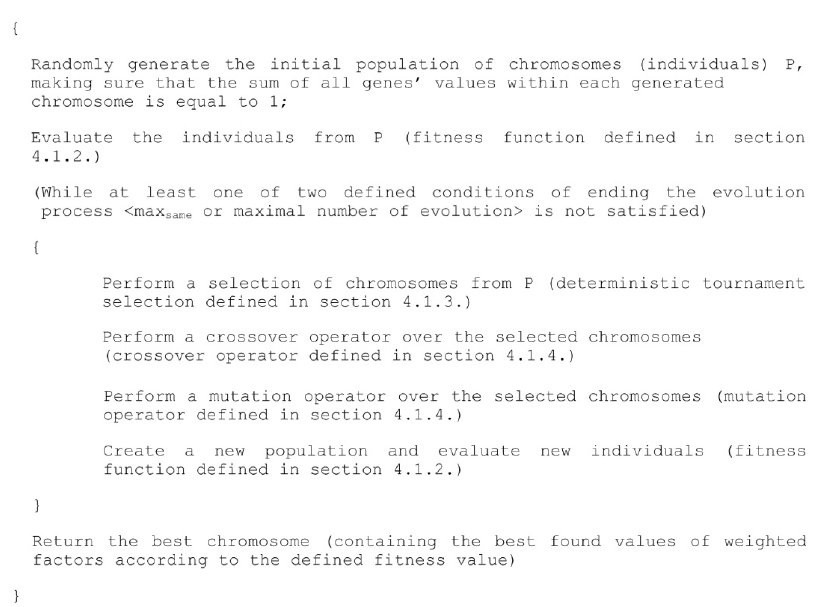
Figure 9. The pseudo code of genetic algorithm for determining the weighted factors of basic